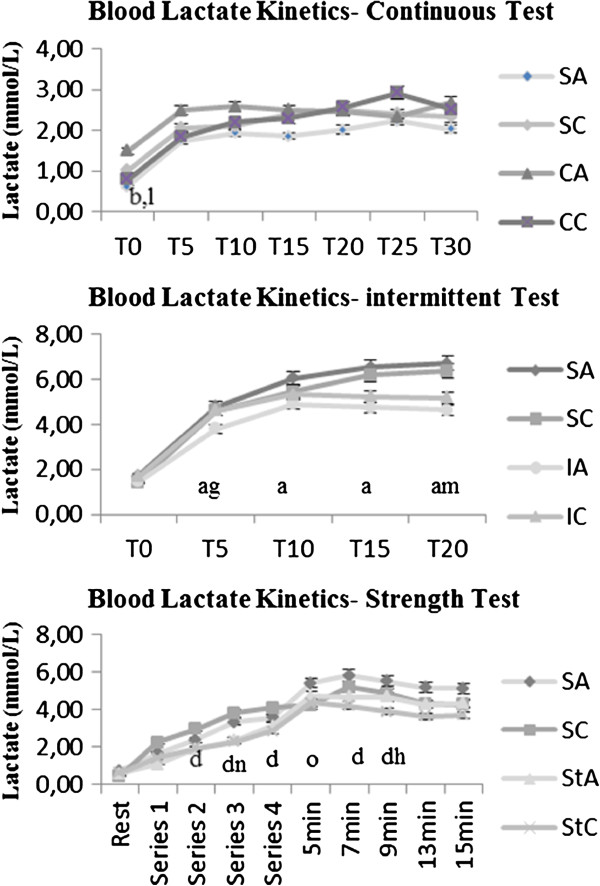
Blood lactate kinetics during the stress test for the continuous, intermittent, and strength training groups. Analyses were conducted at the end of the experiment. The results are expressed as the mean ± SD, n = 10 animals per group. SA: sedentary alloxan, SC: sedentary control, CA: continuous training alloxan, CC: continuous training control, IA: intermittent training alloxan, IC: intermittent training control, StA: strength training alloxan and StC: strength training control. The letters indicate significant differences (two-way ANOVA (3x2) and Newman-Keuls post hoc, p < 0.05)) among the groups. a = significant difference between SA and IA; d = significant difference between SC and StC; g = significant difference between IA and IC; h = significant difference between StA and StC; m = significant difference between SC and IC; n = significant difference between AS and StA, o = significant difference between SA and SC.